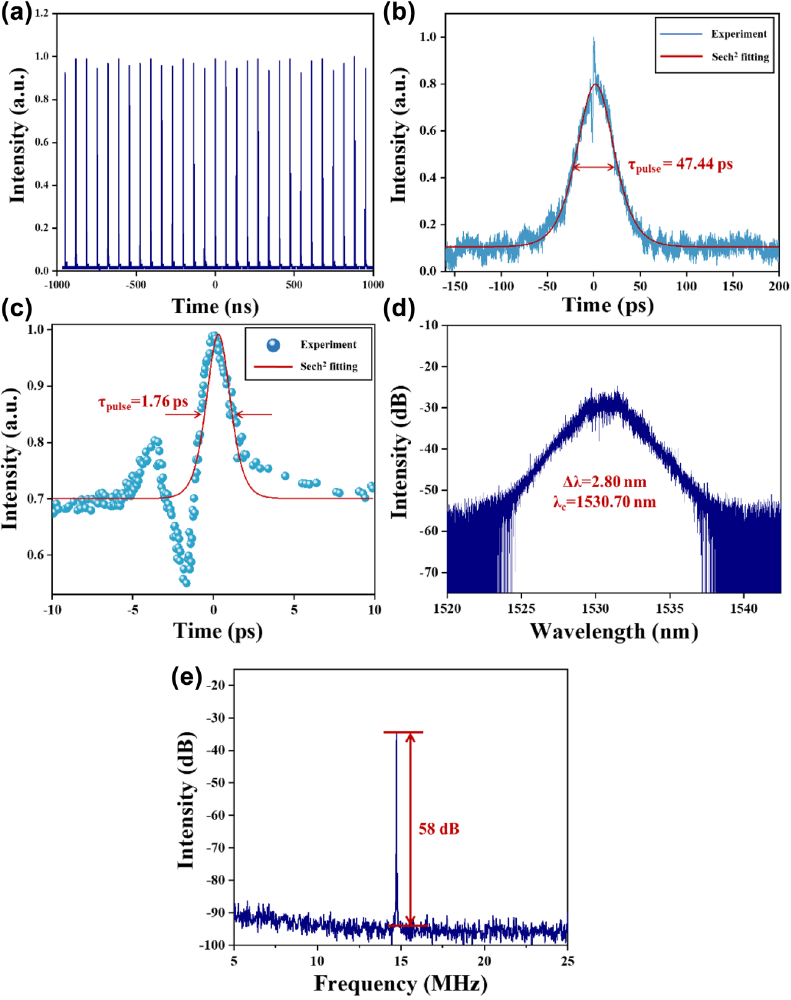
S -SA: (a) Pulse 2 3